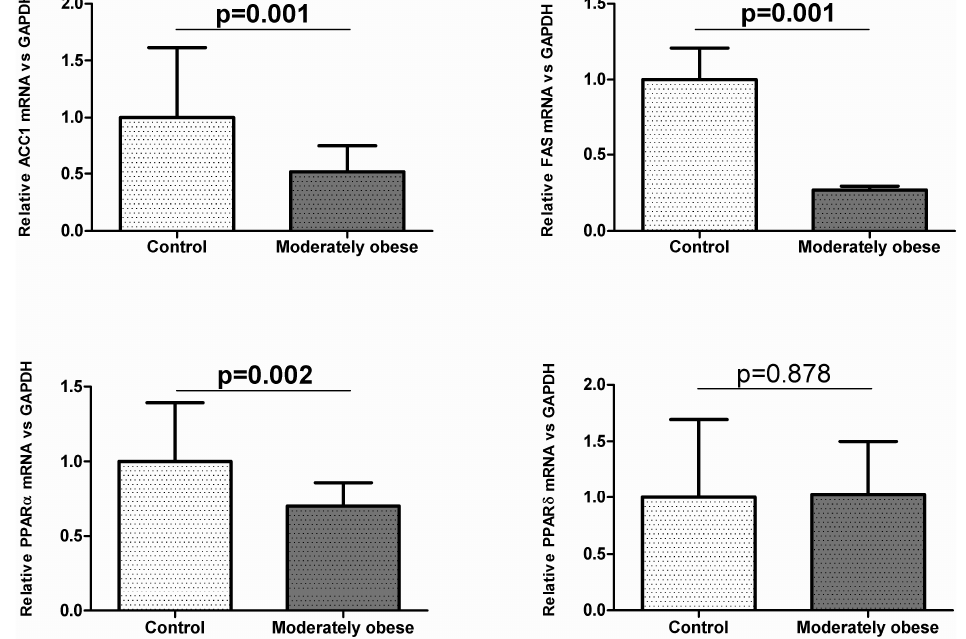
Figure 1. Cont. Figure 1.